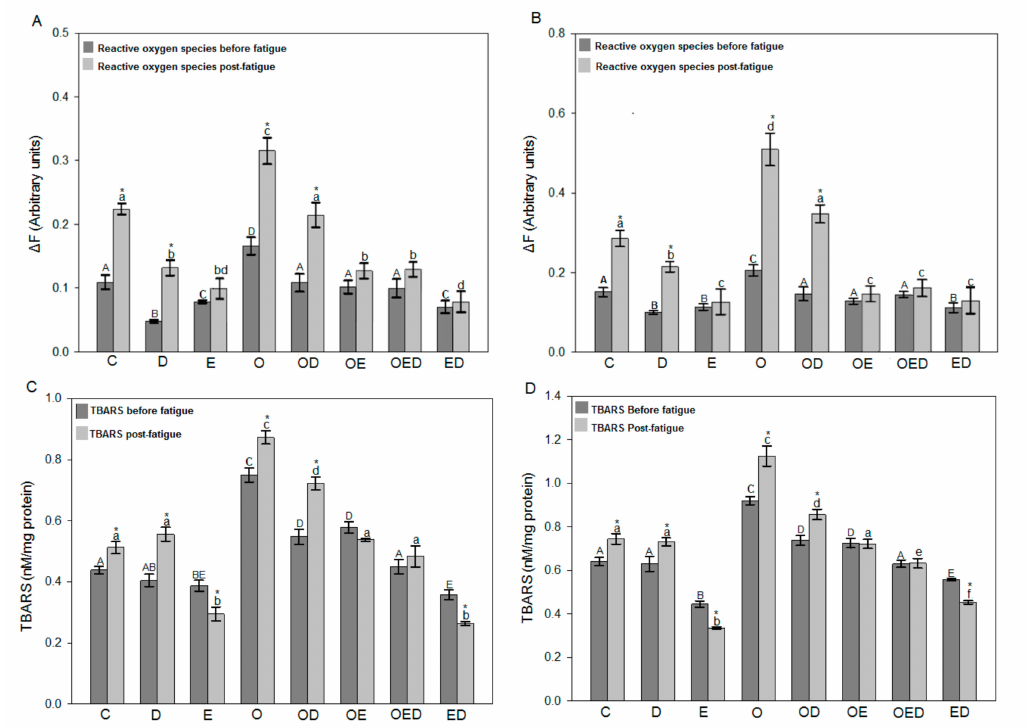
Figure 2. E ff ect of diazoxide and exercise on ROS levels and lipid peroxidation in slow and fast skeletal muscle of obese rats. ( A ) ROS levels in the soleus muscle, ( B ) ROS levels in the EDL muscle, ( C ) TBARS levels in the soleus muscle, and ( D ) TBARS levels in the EDL muscle, before and after fatigue. C: